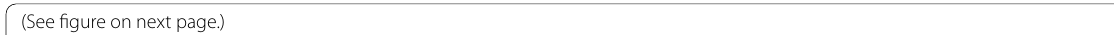
Fig. 5 Visualization results of predictions for the four actions of (a) walking (b) smoking (c) walkingdog (d) greeting (e) eating (f) phoning on Human3.6 M. The ground-truth, LTD [4], HRI [27], and the proposed method are shown from top to bottom. The changes in actions from the first to the last frame of the prediction can be clearly seen in the grey dashed box, while the blue round box shows the comparison between predicted action and ground truth by the proposed method and other methods. It can be seen from the visualization results that the proposed method produces predictions closer to the ground truth than HRI